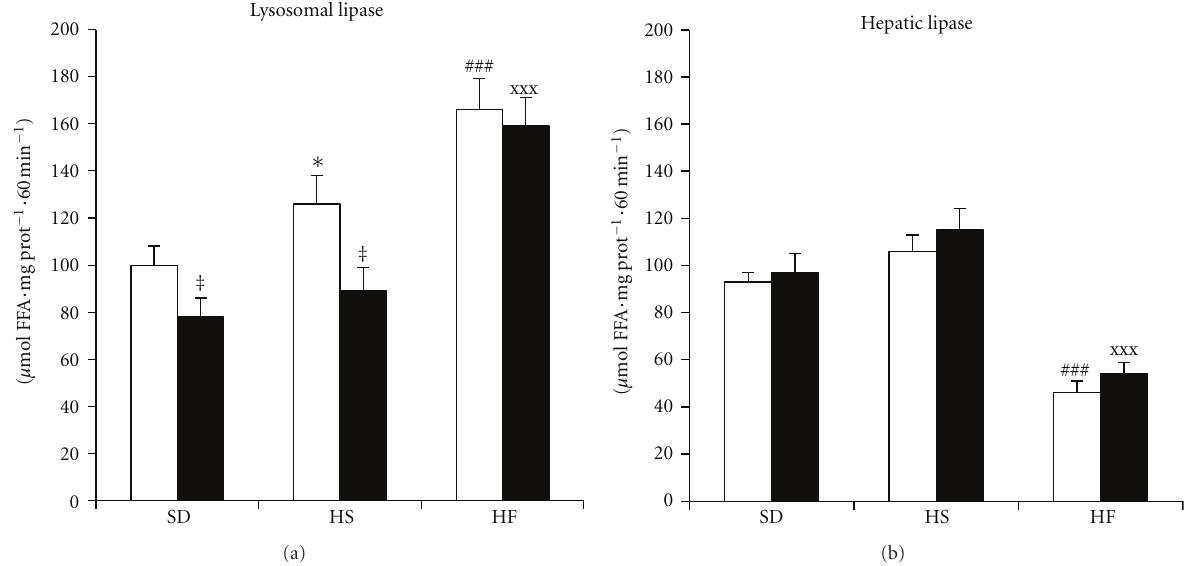
Figure 3: The activity of lysosomal (a) and hepatic (b) lipase in liver homogenate measured as FFA release from artificial substrate ( 3 H- triolein). The lipase activity was measured as the release of fatty acids at pH = 4 . 5 from 3 H triolein. Open bars = fasted animals; closed bars = fed animals. ‡ P < fed versus fasted; ∗ P < 0.05 HS-fasted versus SD-fasted; ### P < 0.001 HF-fasted versus SD-fasted; xxx P < 0.001 HF-fed versus